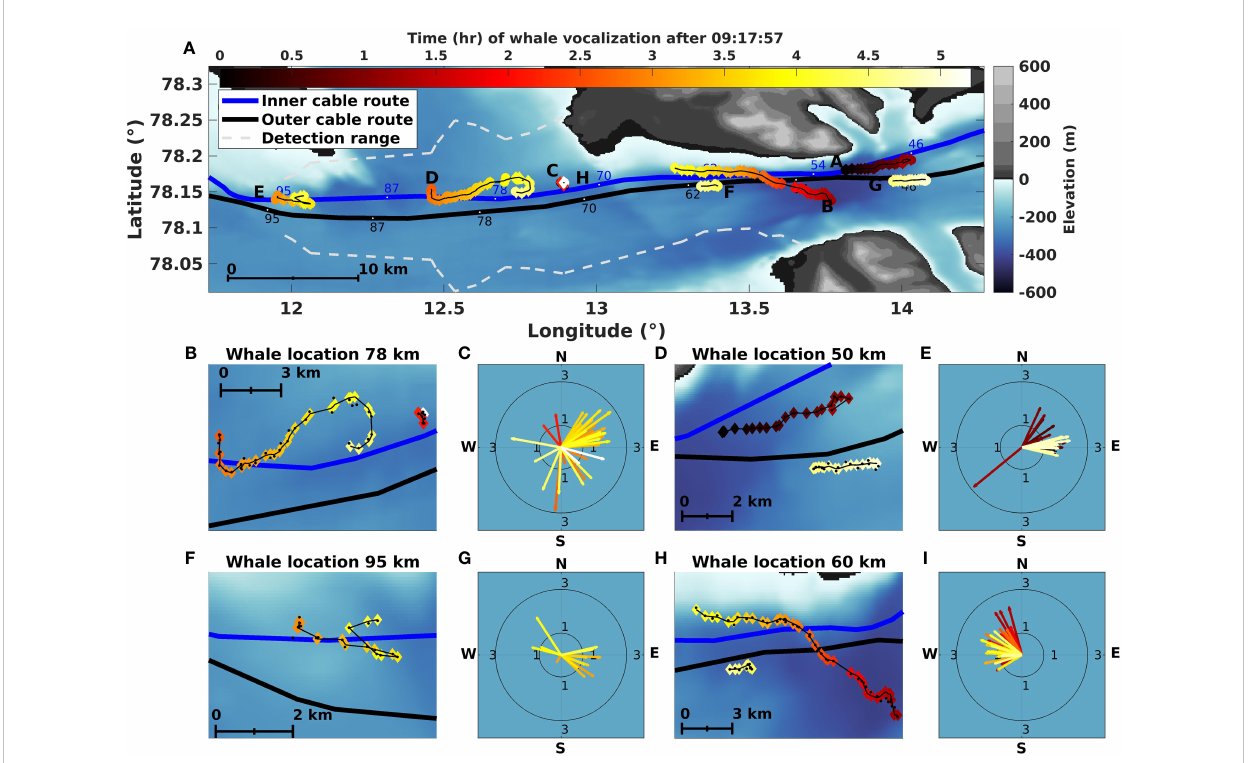
FIGURE 5 Simultaneously tracking multiple whales using fi ber-optic cables in the Arctic. (A) Overview of a 60 km long section of the cables, showing the positions and tracks of up to eight acoustically-detected whales, color-coded from dark to light over a 5.1-hour period. Note that the GS and the BF have been plotted in the same color and shape to better illustrate the tracks. The two dashed lines show an attempt to estimate an empirical whale detection range directly from the DAS data using vocalizations every 10 min for each whale track. (B, D, F, H) Show zoomed-in detailed positions and tracks of the four areas with whale detections. We use the same color coding as in (A) for the BF, while GS has been plotted as black dots to better see the differences in the estimated positions. (C, E, G, I) show the corresponding swim velocities as polar plots for these